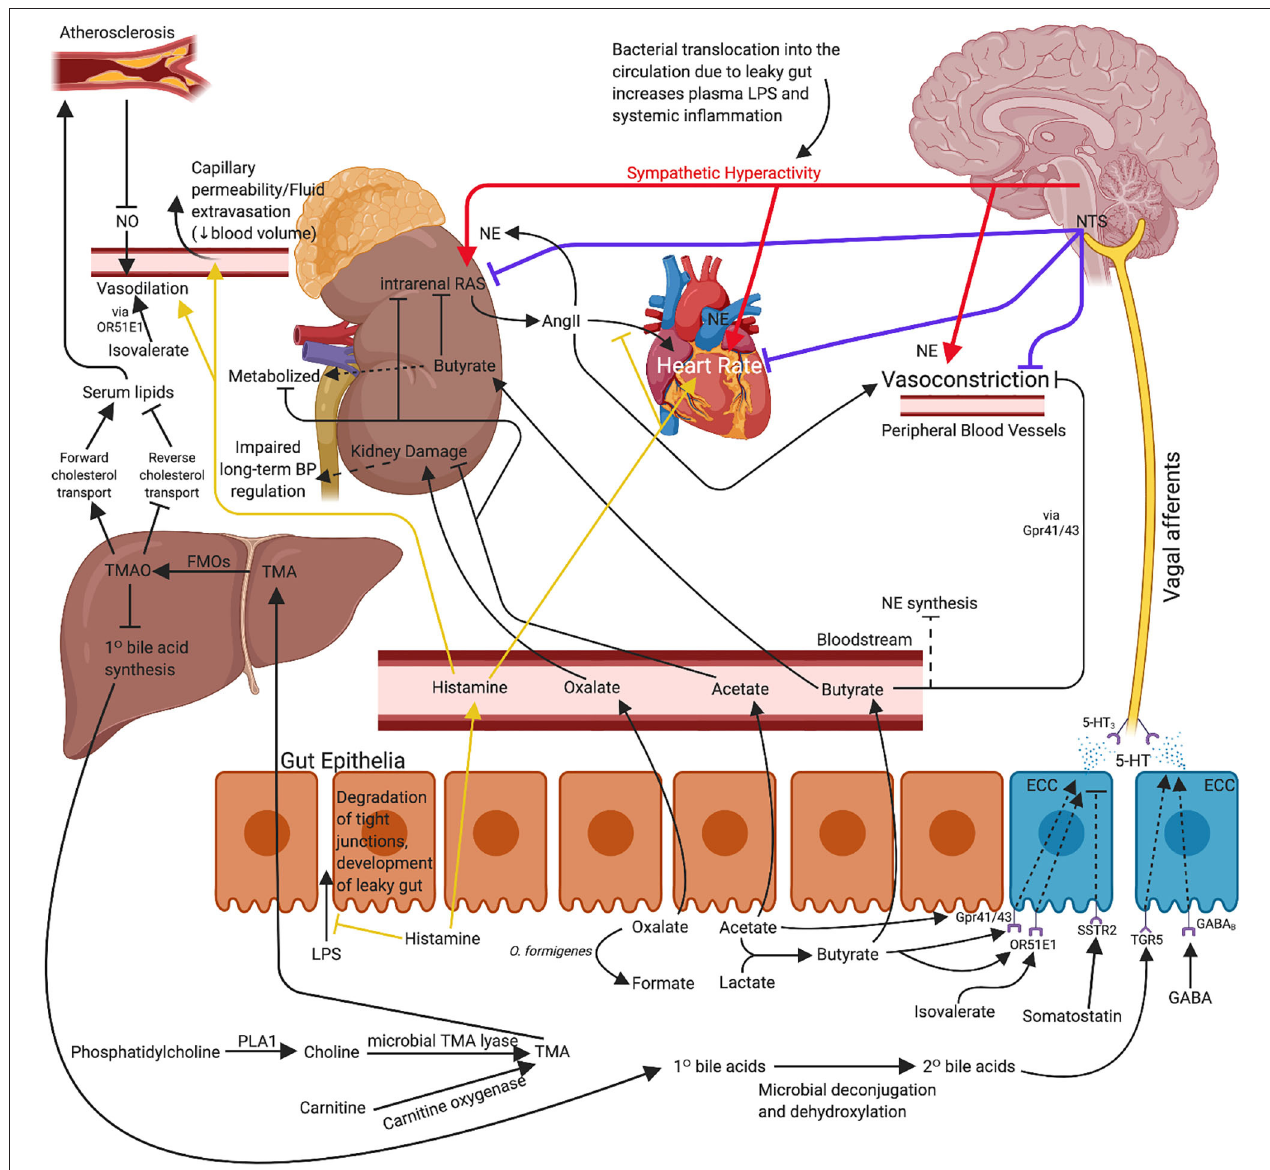
FIGURE 1 | Proposed mechanism for use of probiotic bacteria and associated metabolites for the management or concomitant treatment of hypertension. The effects of propionate and arachidonic acid are not included as the exact mechanisms of action are not yet clear. Immune mechanisms are also excluded for clarity. 5-HT, serotonin; AngII, angiotensin II; BP, blood pressure; ECC, enterochromaffin cell; FMO, flavin monooxygenase; GABA, gamma-aminobutyric acid; LPS, lipopolysaccharide; NE, norepinephrine; NO, nitric oxide; NTS, nucleus tractus solitarius; O. formigenes , Oxalobacter formigenes ; PLA1, phospholipase A1; TMA, trimethylamine; TMAO, trimethylamine- N -oxide. Created with BioRender.com.